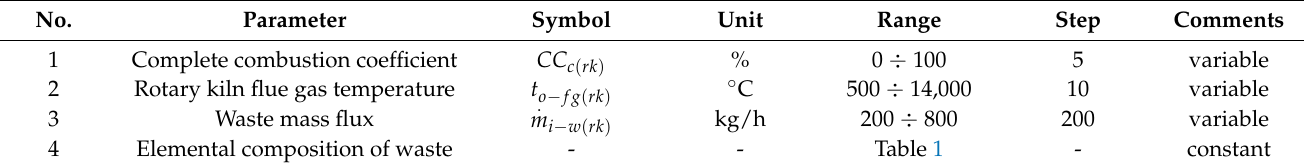
Table 2. Model research